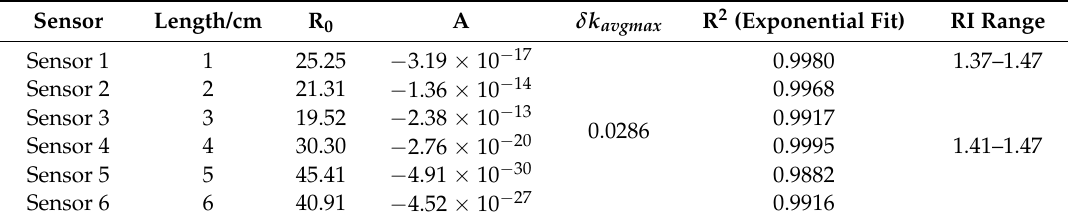
Table 2. RI: 1.41–1.47—Obtained parameters given by Equations (7) and (15), that allow the resolution and sensitivity of the D-shaped sensors to be calculated,